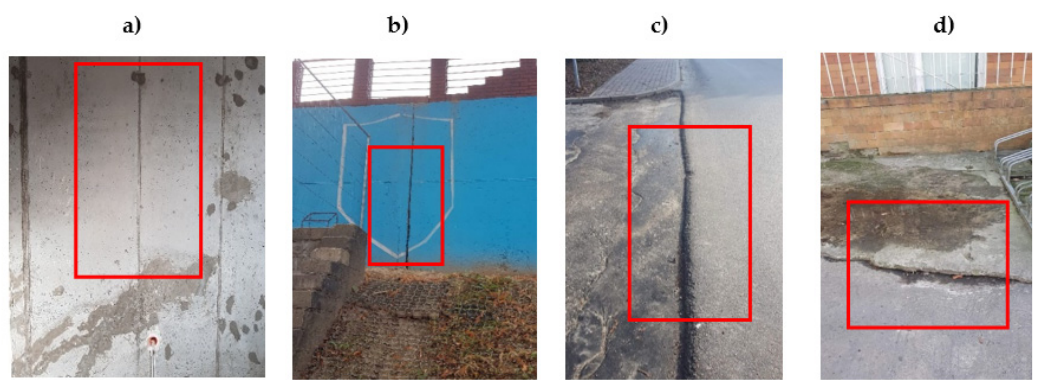
Figure 3. Photos of the objects and areas of study (marked with a red rectangle) ( a ) a precast concrete